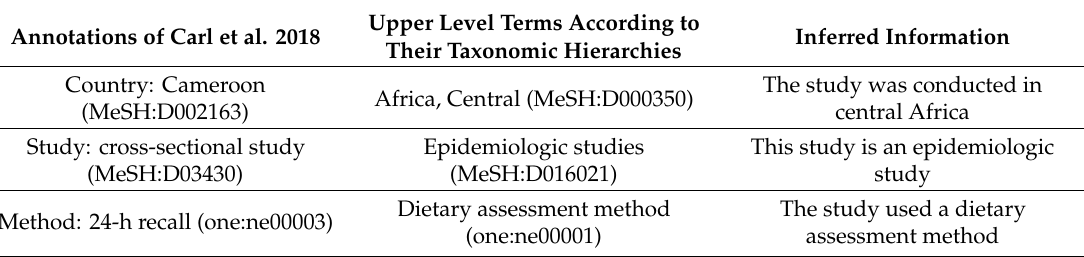
Table A6. Case study: ontology-based